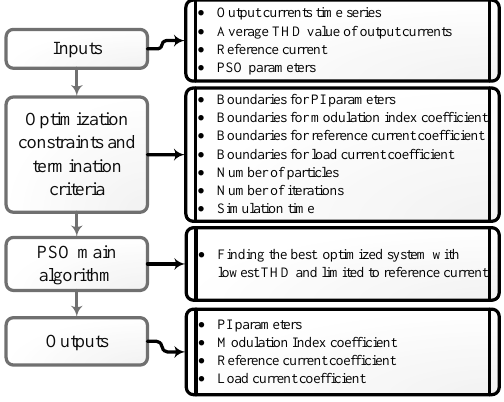
Figure 5. The proposed Particle Swarm Optimization (PSO) algorithm.